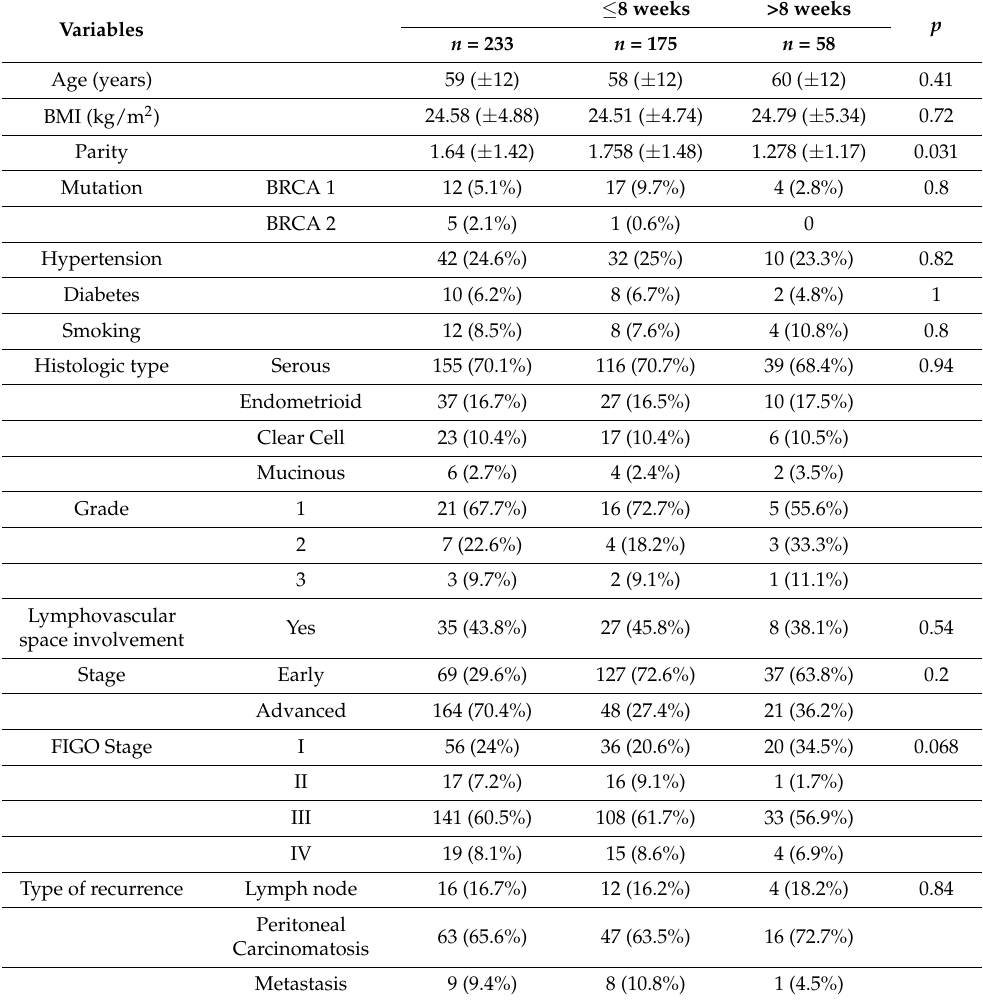
FIGO: International Federation of Gynecology and